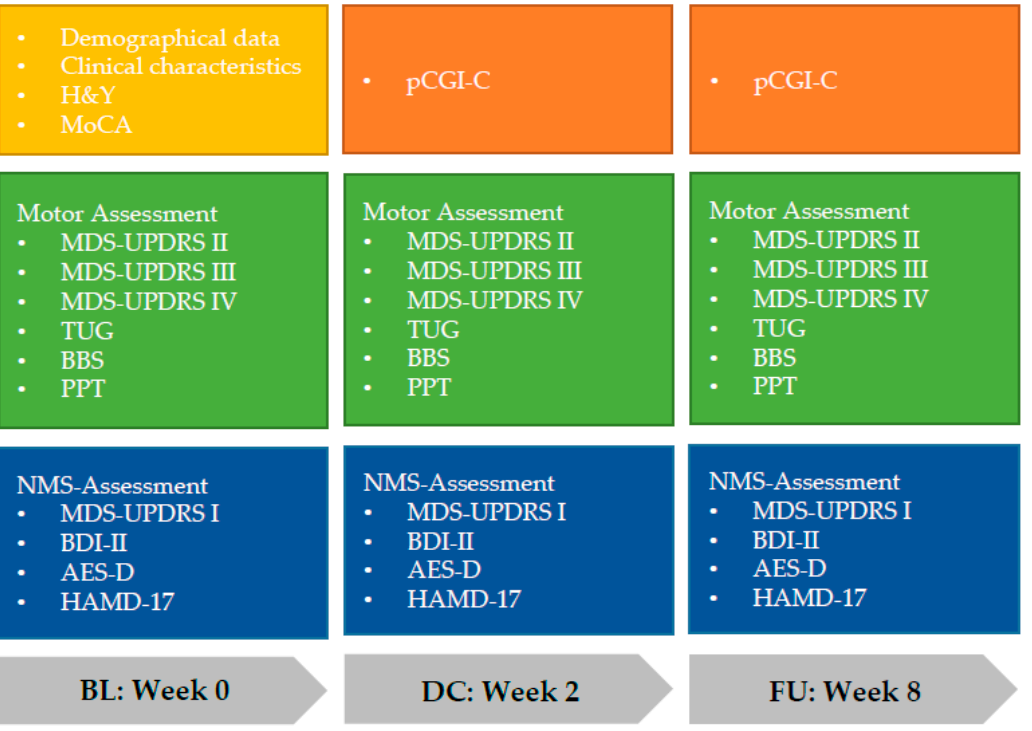
Figure 1. Type and Timing of Clinical Assessments. H&Y: modified Hoehn and Yahr stage, MoCA: Montreal Cognitive Assessment, MDS-UPDRS: Movement Disorders Society Unified Parkinson’s Disease Rating Scale, Part I–IV, TUG: Timed Up and Go Test, BBS: Berg Balance Scale, PPT: Purdue Pegboard Test, NMS: Non-Motor Symptom, BDI-II: revised Beck Depression Inventory, AES: Apathy Evaluation Scale, HAMD-17: Hamilton Rating Scale for Depression, pCGI-C: Patient’s Clinical Global Impression of Change, BL: Baseline, DC: Discharge, FU: Follow-Up.